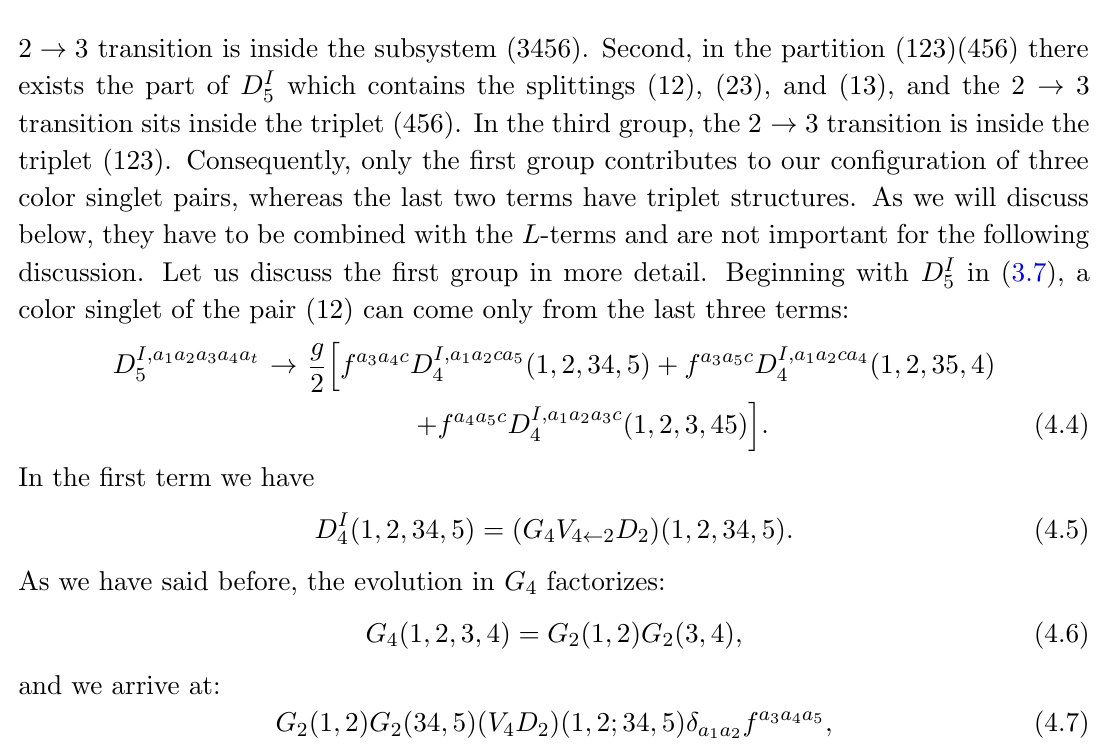
Figure 9 . The three terms emerging from the D I partition (12)(3456), the second and third ones to the partition (123)(456).